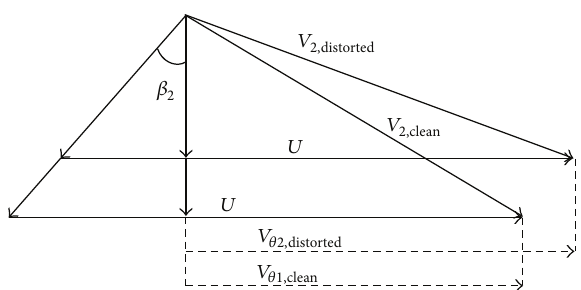
Figure 2: Velocity triangles.